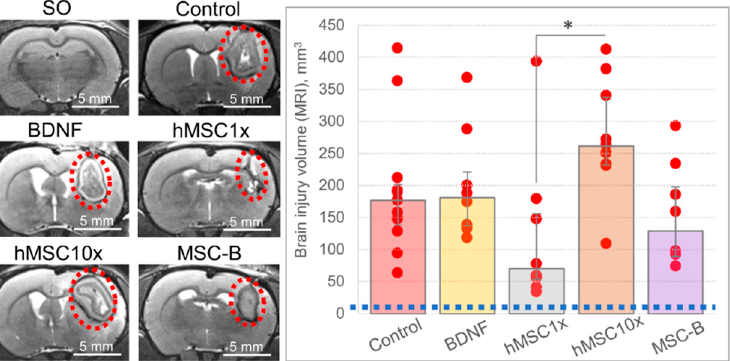
Figure 3. The results of the MRI examination of the brain at day 11 after the intracerebral hemorrhage. On the diagram: the blue dashed line equals the volume of the brain lesion site in the SO animals. Data is presented as a median (25%; 75%). [*—H (4,35) = 11.841; p = 0.019; n ≥ 8; ANOVA on ranks].